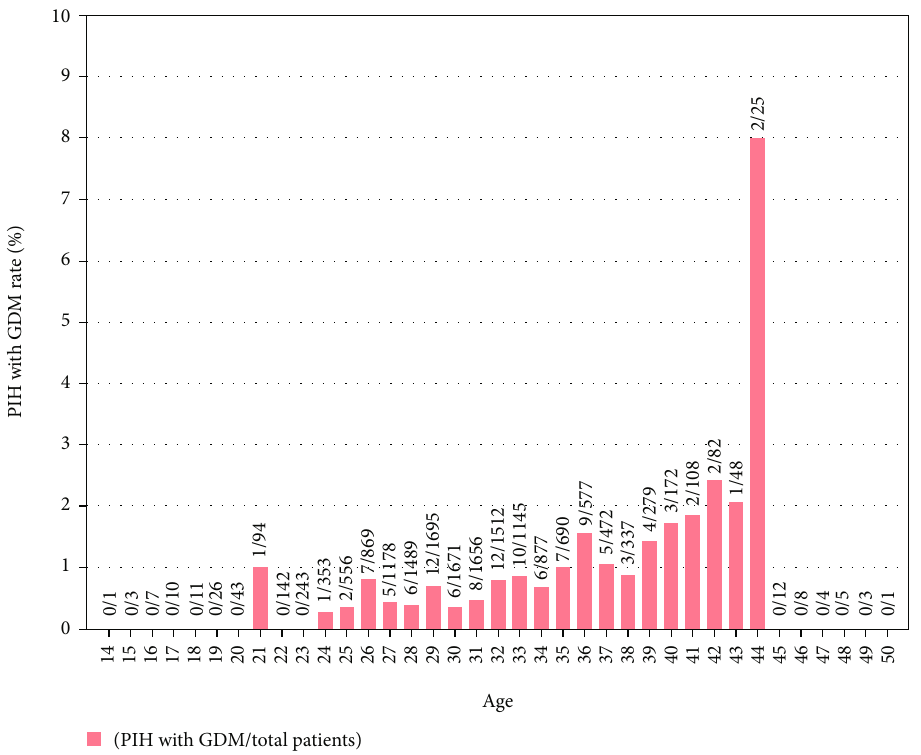
Figure 3: PIH rate distribution histogram with